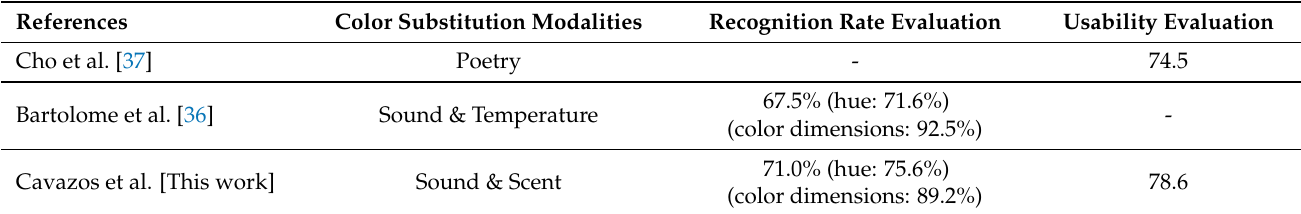
Table 2. Comparison of an existing multi-modal color codes in terms of user